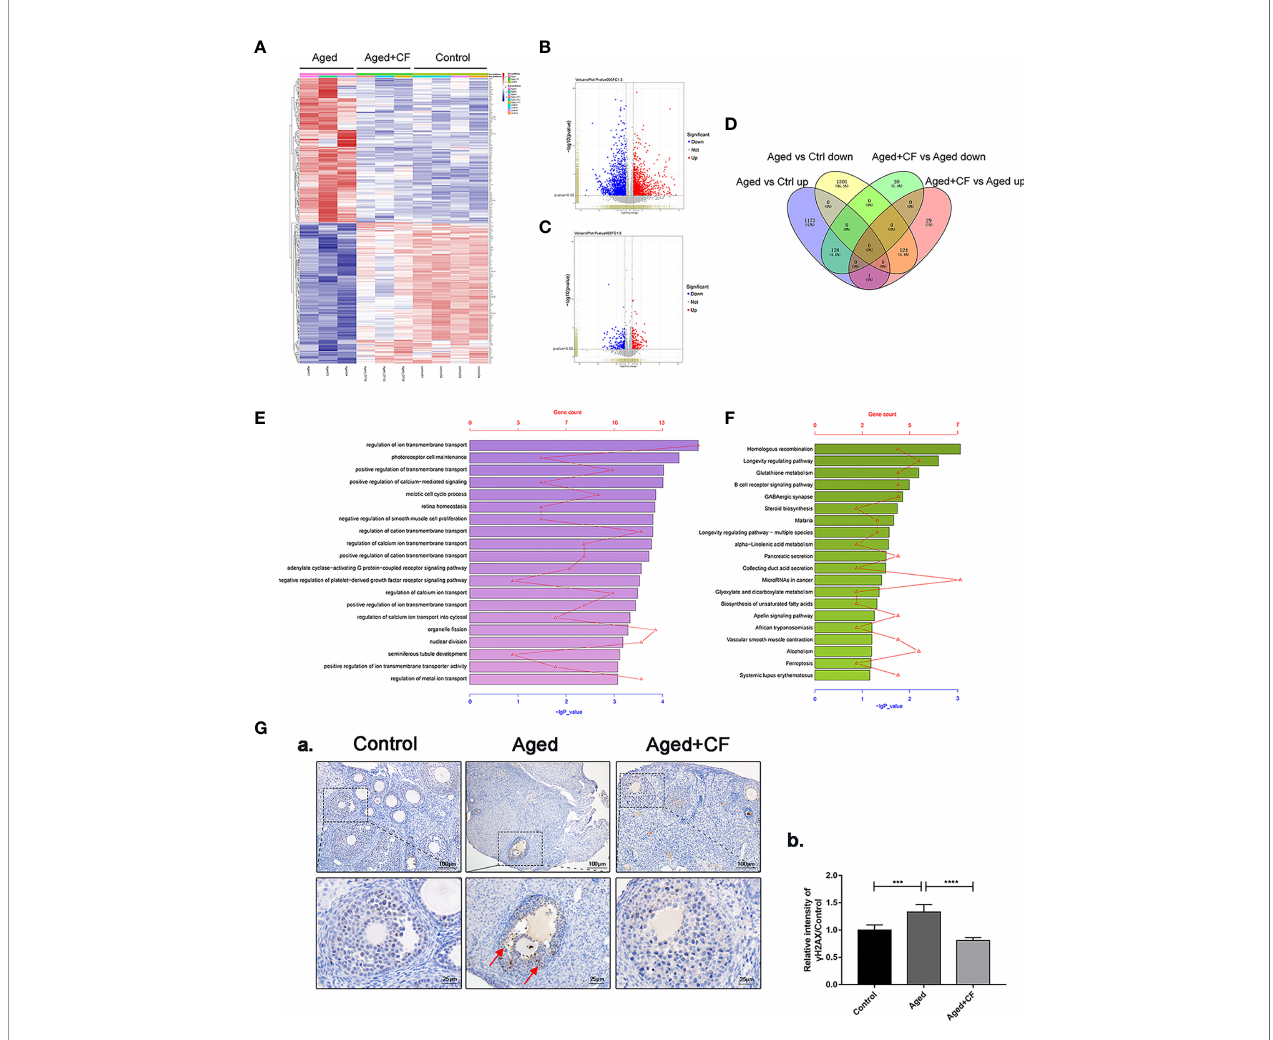
FIGURE 4 | Transcriptome and Bioinformatics Analyses of Ovaries. (A) Heatmap of differentially expressed genes (DEGs) from Aged vs Aged+CF vs Control group with absolute fold change of more than 1.5 and P value of less than 0.05. Aged group: n=3, Aged+CF group: n=3, Control group: n=4 (B) The volcano plot of DEGs of Aged vs Control. Among the total 2,727 genes, 1,302 genes were upregulated while 1,425 genes were downregulated. (C) The volcano plot DEGs of Aged+CF vs Aged. Among the total 321 genes, 154 genes were upregulated while 167 genes were downregulated. (D) Venn analysis of Aged vs Control and Aged+CF vs Aged group, following which, 252 DEGs with opposite trends in the two clusters were selected. (E) DEGs derived from Venn analysis were further analyzed via GO analysis. (F) DEGs derived from Venn analysis were further analyzed via KEGG analysis. (G) IHC staining of g H2AX of ovarian sections (a) and statistical analysis (b) (n=5), scale bar=100 m m or 25 m m. Data are represented as the mean ± SD, *** P < 0.001, and **** P <